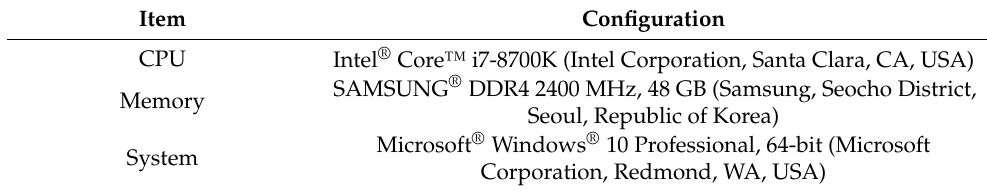
Figure 1. Technical flowchart. Table 1. Configuration of the computer in this